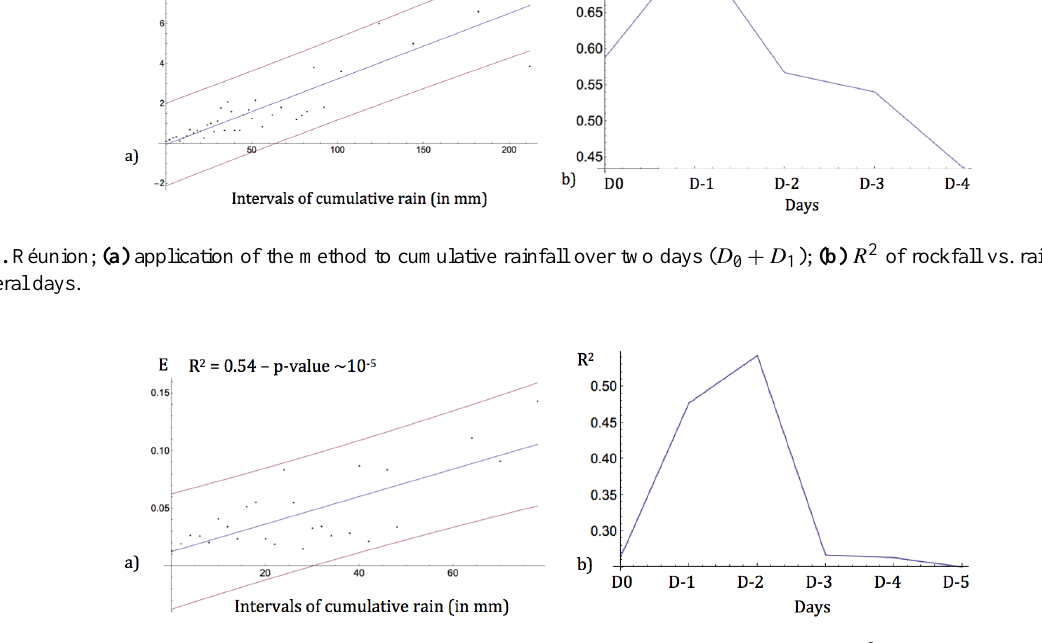
Figure 8. Same as Fig. 7 for Burgundy. Cumulative rainfall over three days ( D 0 + D 1 + D 2 ) (a) . (b) R 2 of rockfall vs. rain accumulated over several days.